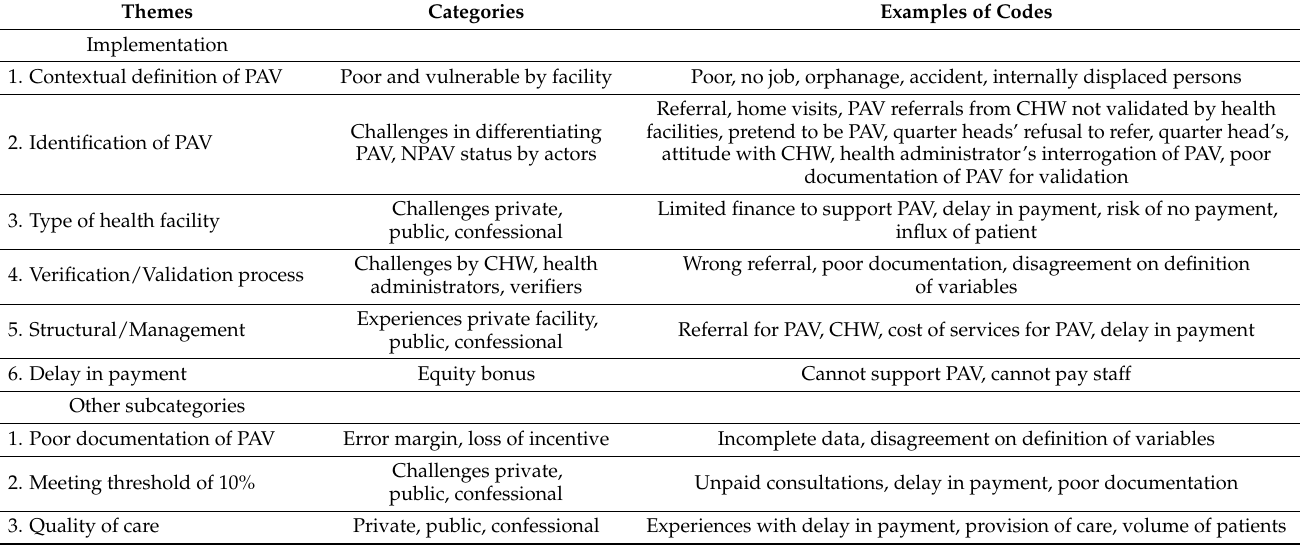
Table 3. Themes generated from the